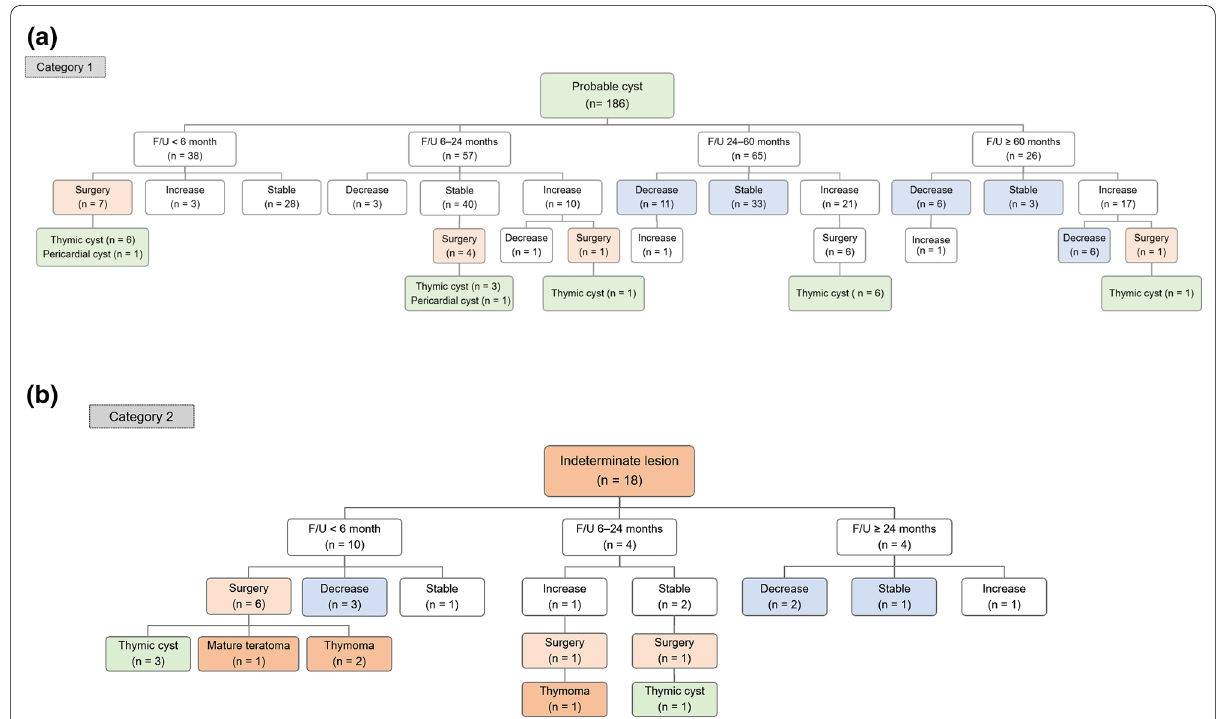
Fig. 3 Follow-up outcomes of anterior mediastinal cystic lesions—stratified based on MRI findings and follow-up outcomes. Follow-up outcomes in patients with probable cyst ( a ) and indeterminate lesion ( b ) on chest MRI